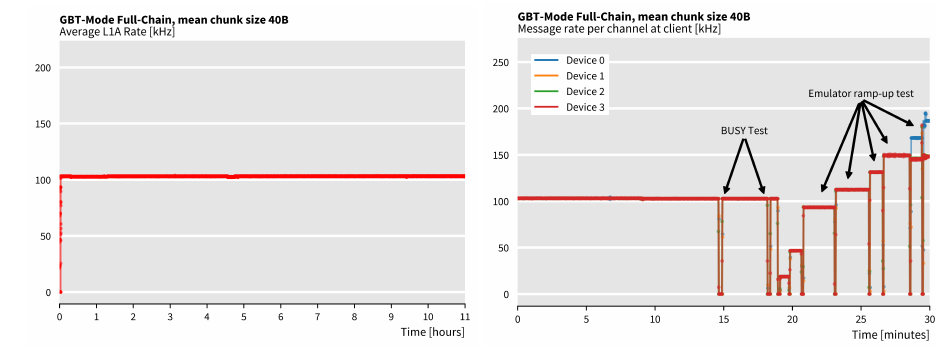
Figure 4. (left) Average L1 Accept rate in GBT mode performance test for all FELIX devices hosted by a single server. (right) BUSY and stress test results for GBT mode, split by FELIX device. Each device corresponds to 50 % of a FLX-712 card, as described in Section 5, hence four devices implies two FLX-712 cards hosted by the server. It was possible to run stably on all four devices up to a 150 kHz rate. The ’client’ in the title refers to the application running on the data sink server.